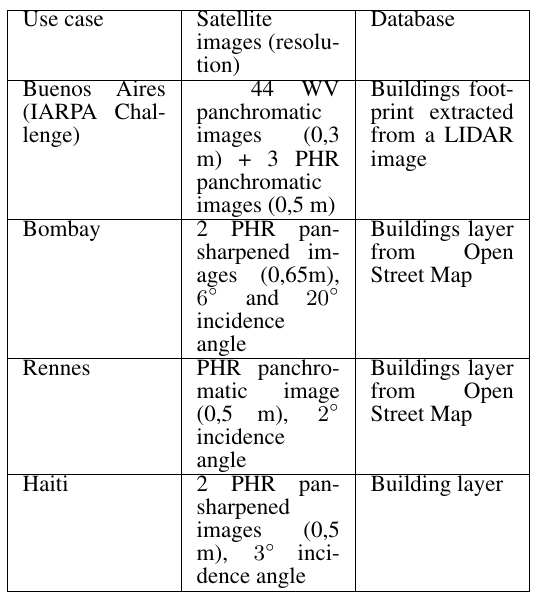
Table 3. Description of the datasets